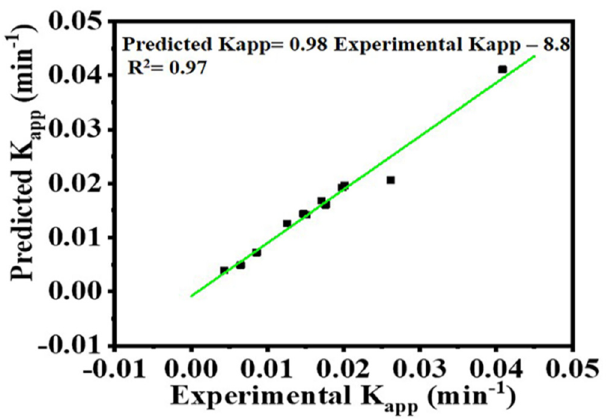
Figure 10. Comparison of experimental K app and predicted K app